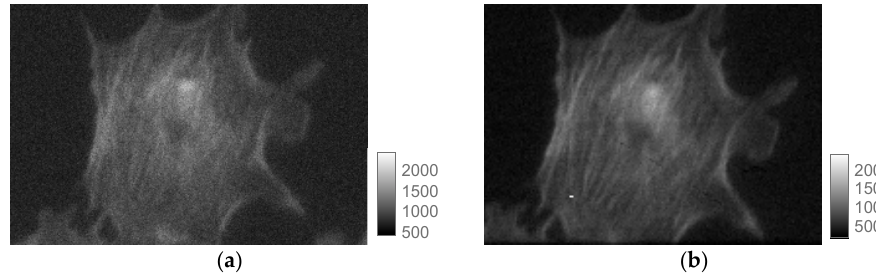
Figure 11. BPAE cell imaging. The cells were labeled with MitoTracker Red CMX Ros, Alexa Fluor 488, and DAPI dyes and imaged in a microscope using two ports matching the photon counts per pixel in each sensor. ( a ) shows the EMCCD and ( b ) the SwissSPAD images obtained with 10 ms and 73.4 ms exposure, respectively. The scales indicate photon counts per frame.